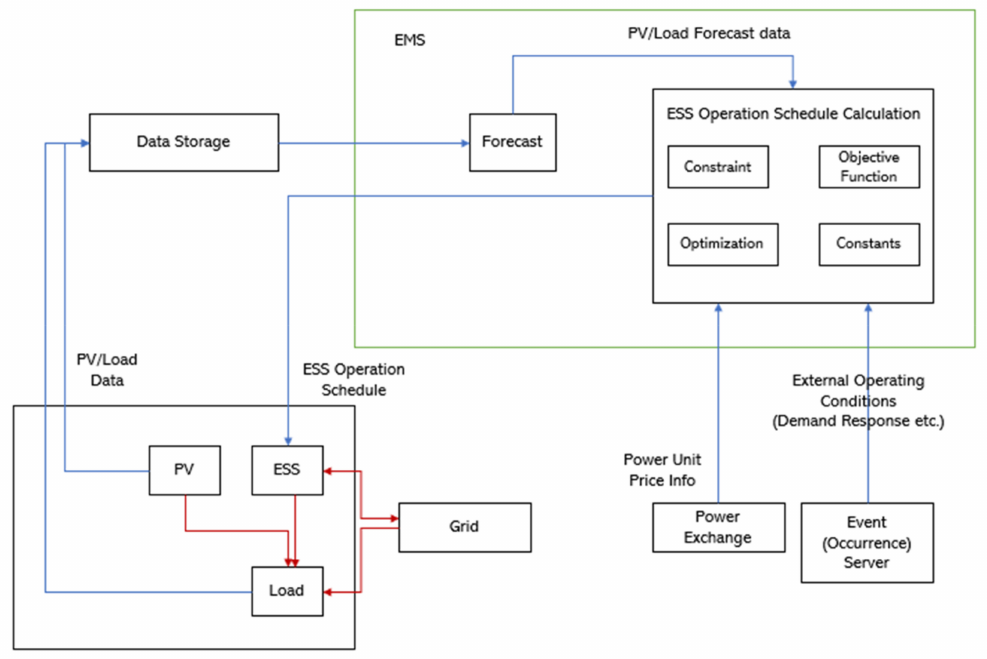
Figure 1. System diagram (red arrow: supply of power; blue arrow: flow of information).